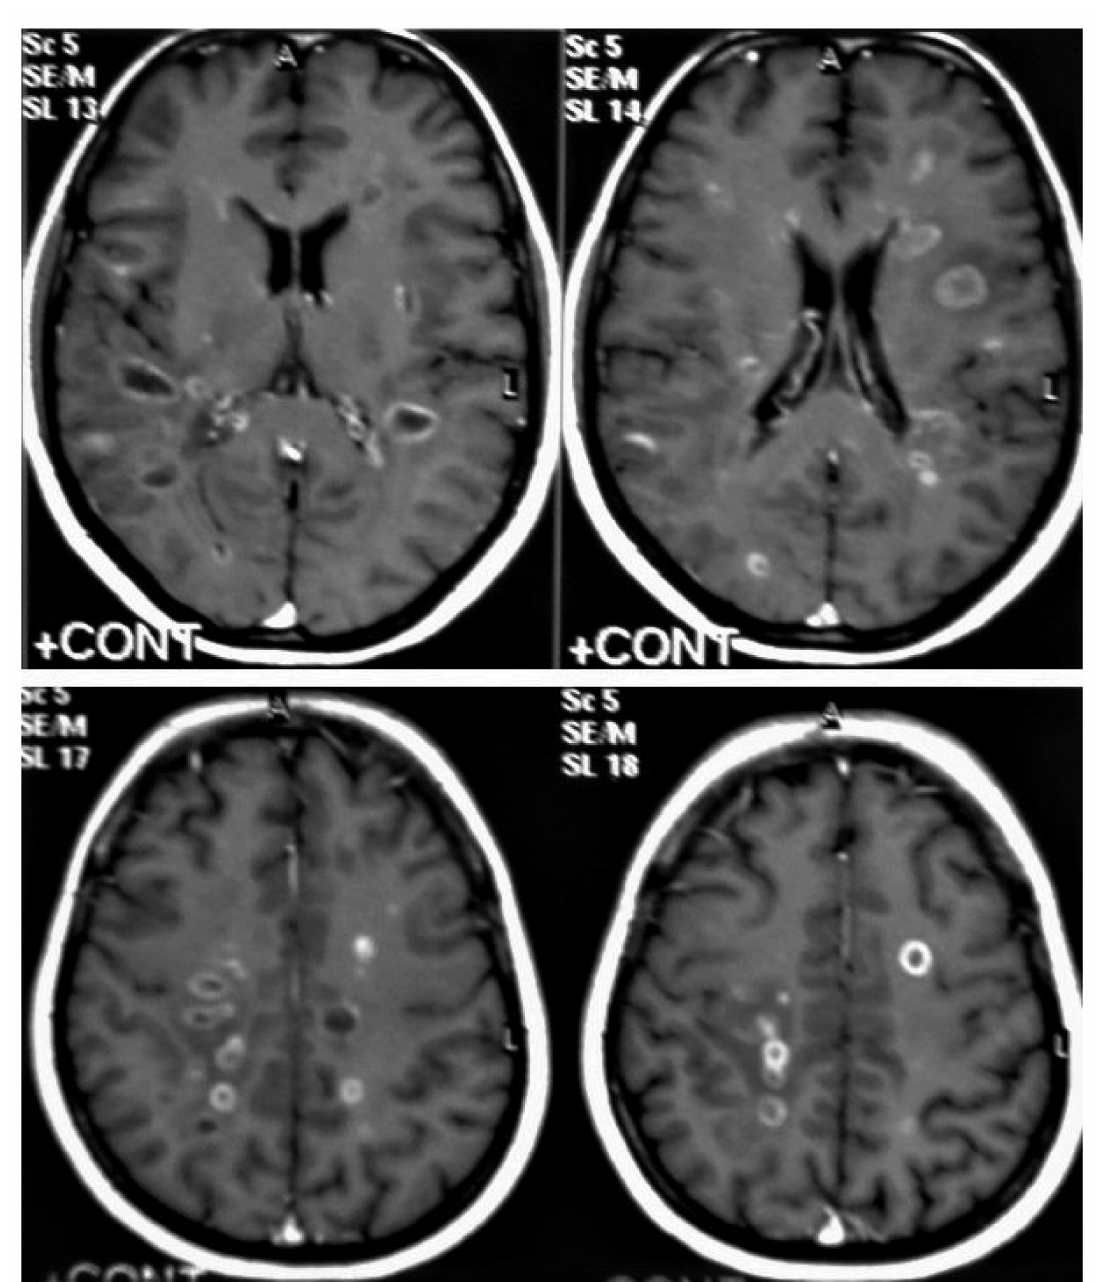
Figure 13. Multiple tuberculomas in an adult man. Selected MRI axial images post-contrast T1- weighted images show multiple small ring-enhancing lesions distributed in both cerebral hemi- spheres, with no significant surrounding cerebral edema, as is consistent with cerebral